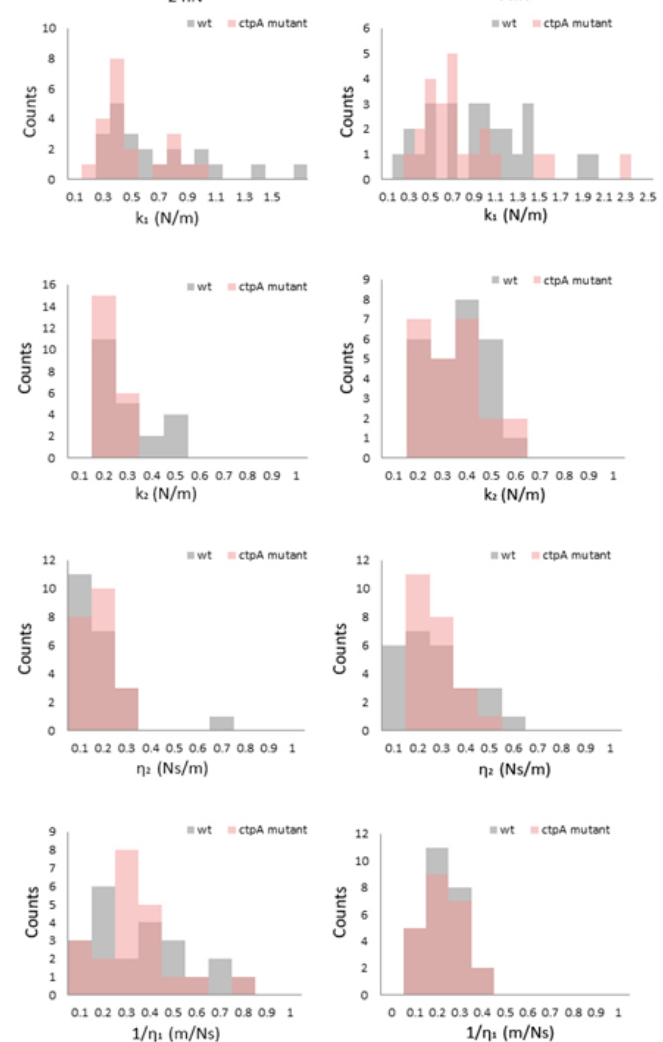
Figure 4. Histograms of viscoelastic parameters k 1 , k 2 , η 2 , 1 / η 1 for Rhizobium leguminsarum bv. viciae 3841 (wt, grey) and 3845 ( ctpA mutant, pink) at low loading forces (2, 4 nN) during creep deformation experiments. k 1 and k 2 are elastic spring constants, and η 1 and η 2 are viscosity parameters from the Burgers model, in which the Maxwell and Kelvin–Voigt models are connected in series.